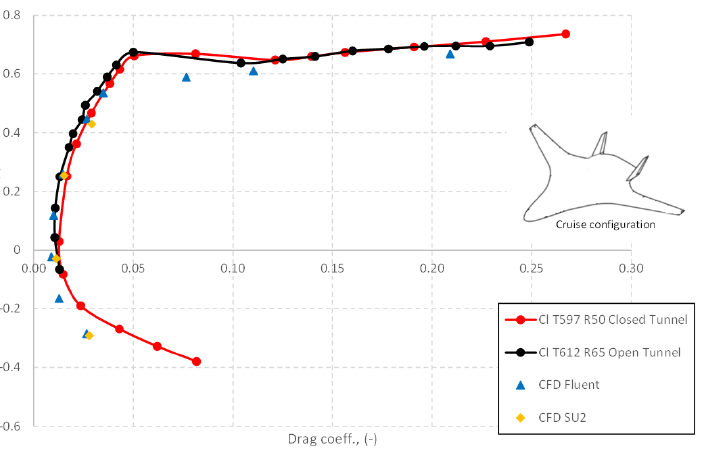
Figure 14. Drag polar. Comparison between present results and literature data [6,14–16].